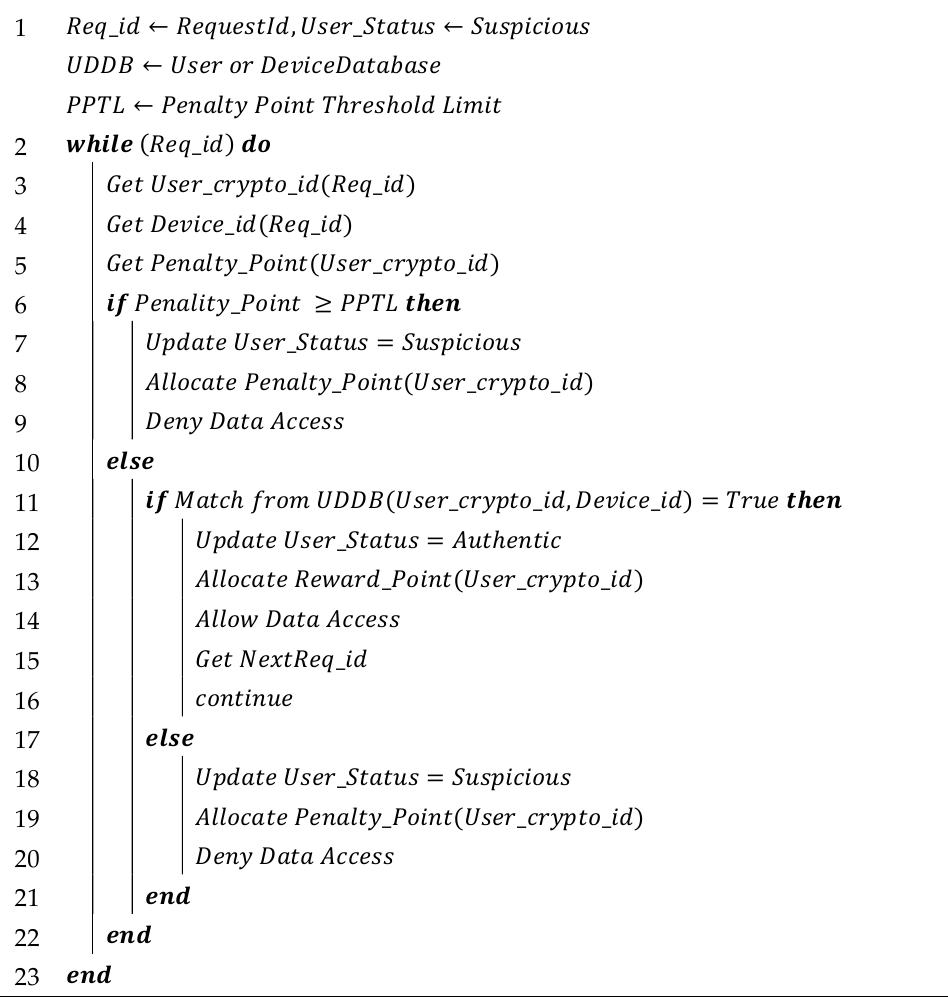
Figure 6. IPFS communication.